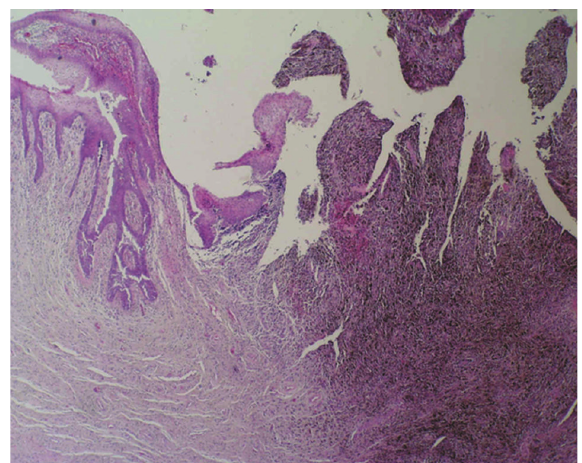
Figure 1: Polypoid, partially ulcerated melanoma of the female urethra (haematoxylin and eosin stain × 40).